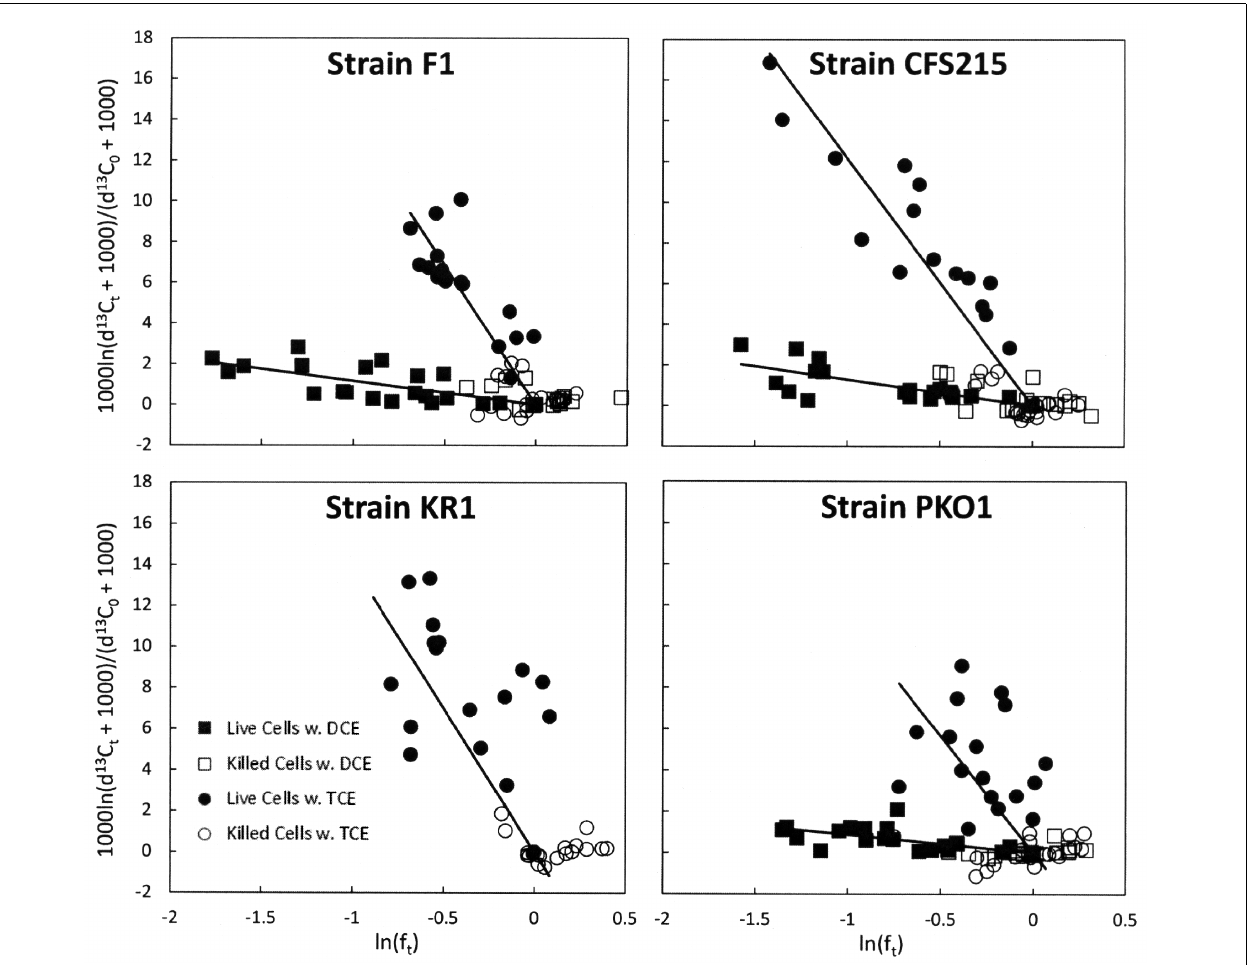
FIGURE 2 | Rayleigh plots of 13 C during degradation of cis -1,2-dichloroethene (c-DCE) and trichloroethene (TCE) by four bacterial strains: Pseudomonas putida F1, P. fluorescens CFS215, P. mendocina KR1, and Ralstonia pickettii PKO1.